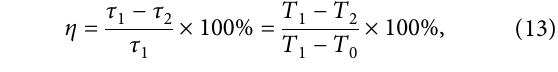
Figure 5: Principle of deep separable